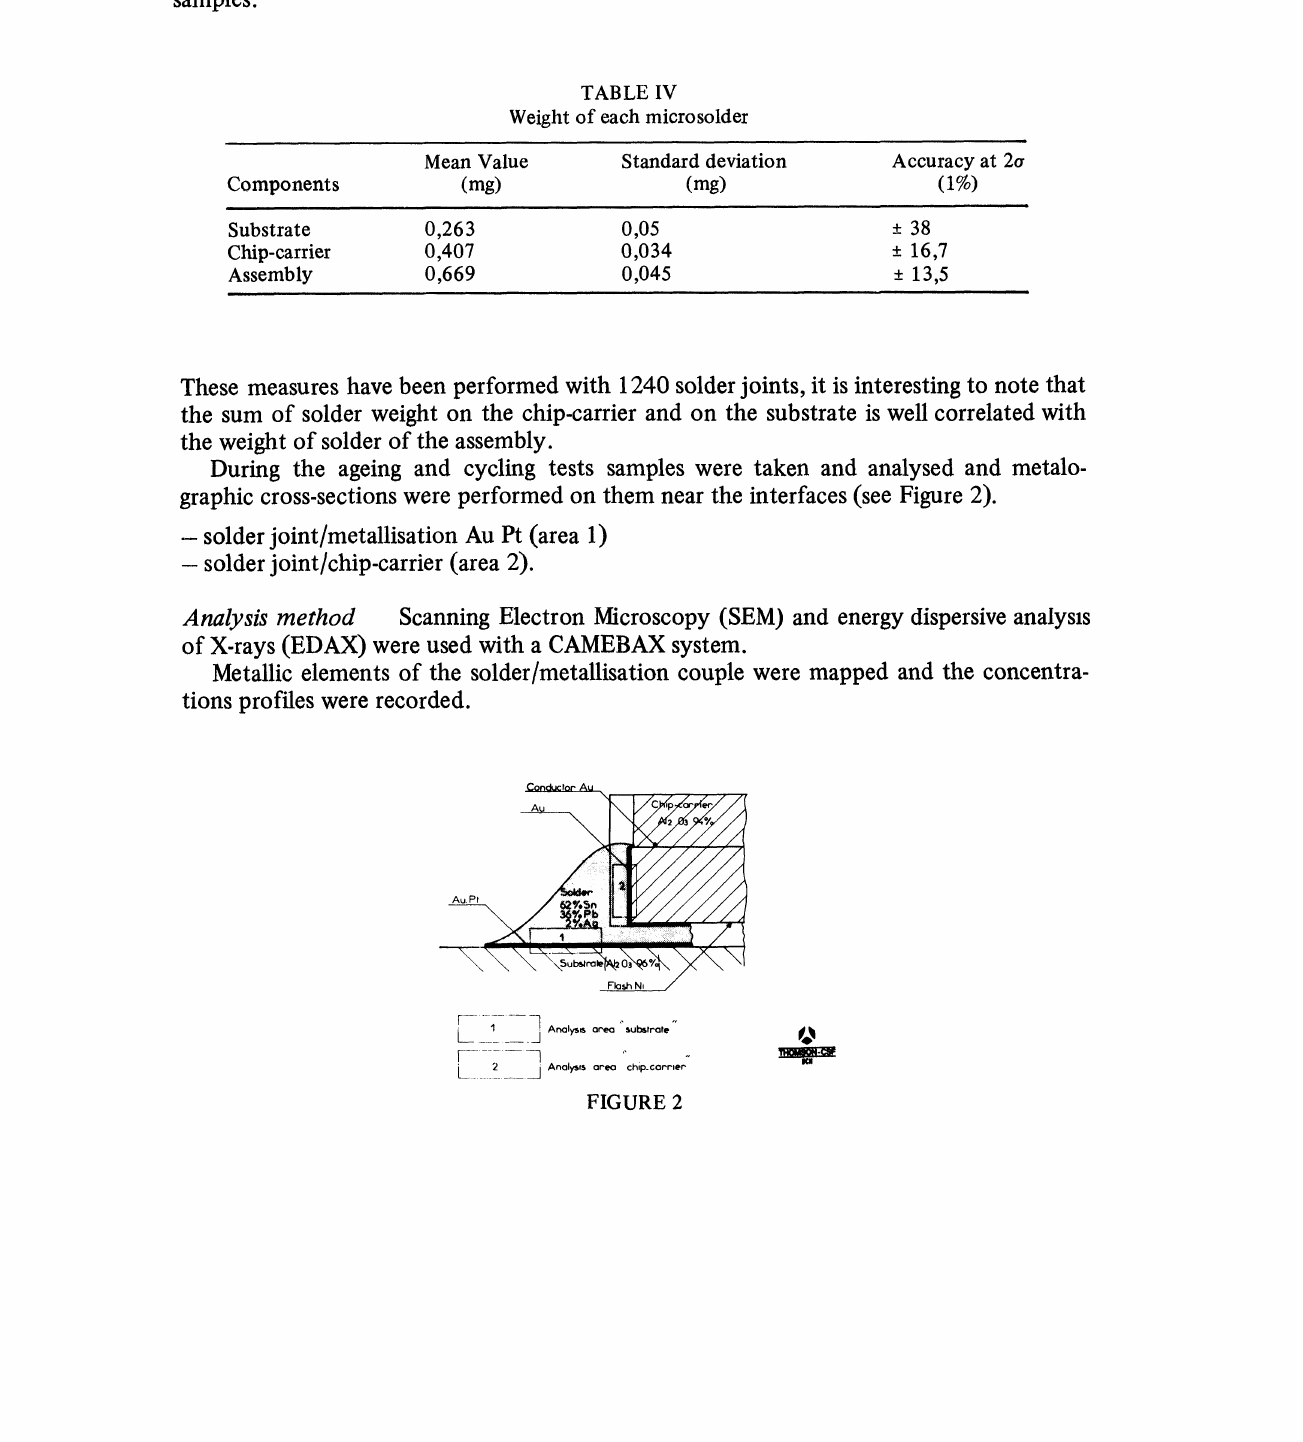
Weight of each microsolder